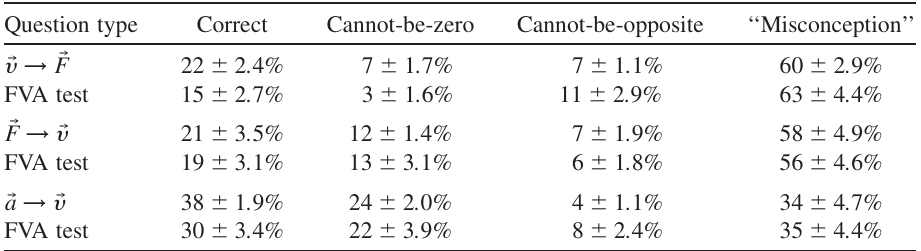
TABLE VII. Comparison of average response choice percentages for the FVA test and the ‘‘multiple context’’ tests (which include six different story contexts) for each question type. Reported are averages (cid:2) standard error between the